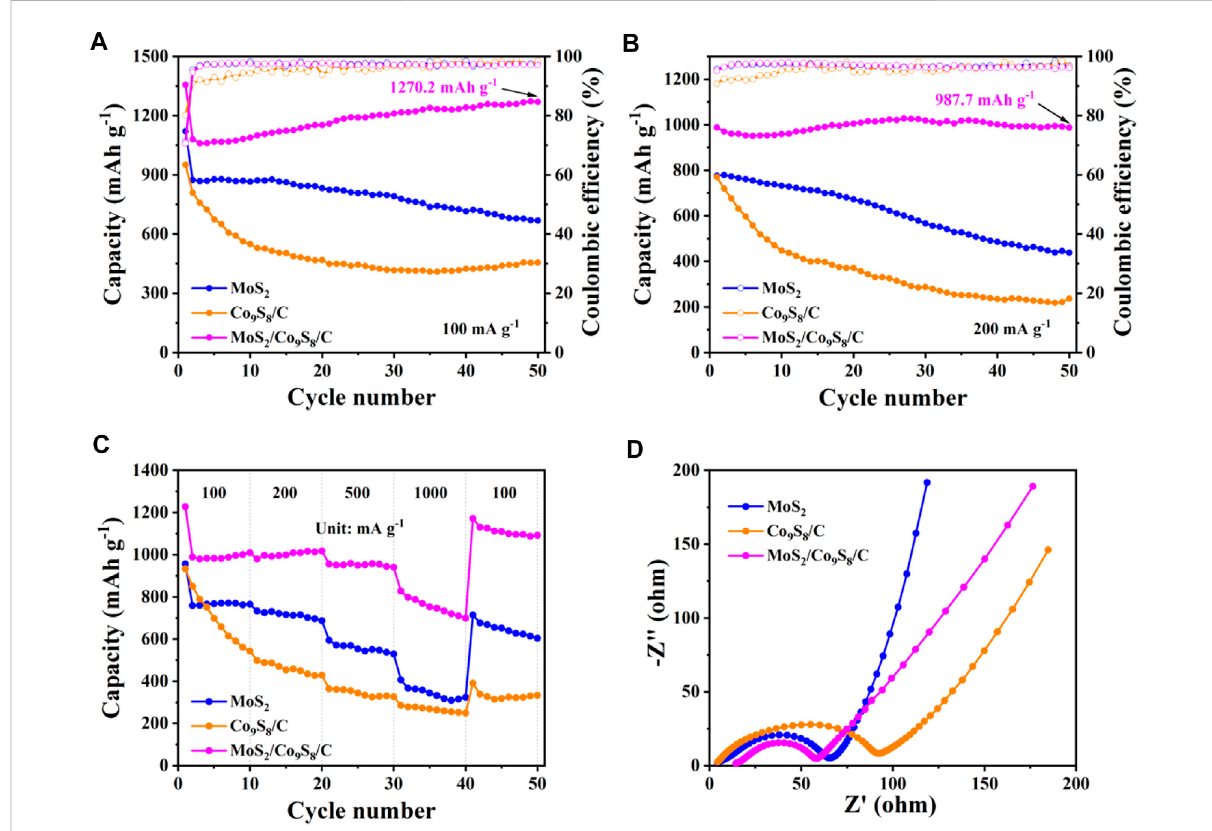
FIGURE 7 Cycling performance together with Coulombic ef fi ciency of MoS 2 /Co 9 S 8 /C, MoS 2 , and Co 9 S 8 /C at a current density of (A) 100 mA g − 1 and (B) 200 mA g − 1 , respectively. (C) Rate capability performance of MoS 2 /Co 9 S 8 /C, MoS 2 , and Co 9 S 8 /C. (D) Nyquist plots of MoS 2 /Co 9 S 8 /C, MoS 2 , and Co 9 S 8 /C in the frequency range between 100 kHz and 10